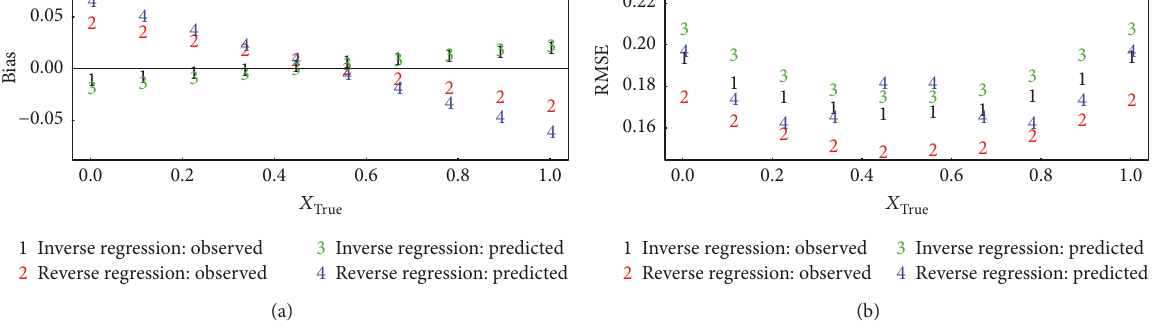
Figure 1: Simulation results for both inverse and reverse regression for (a) the observed and predicted bias versus 𝑋 and predicted RMSE versus 𝑋 True